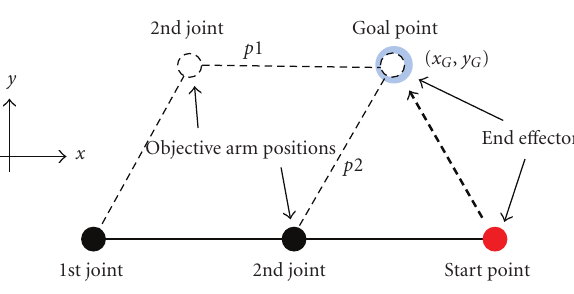
Figure 2: Positioning